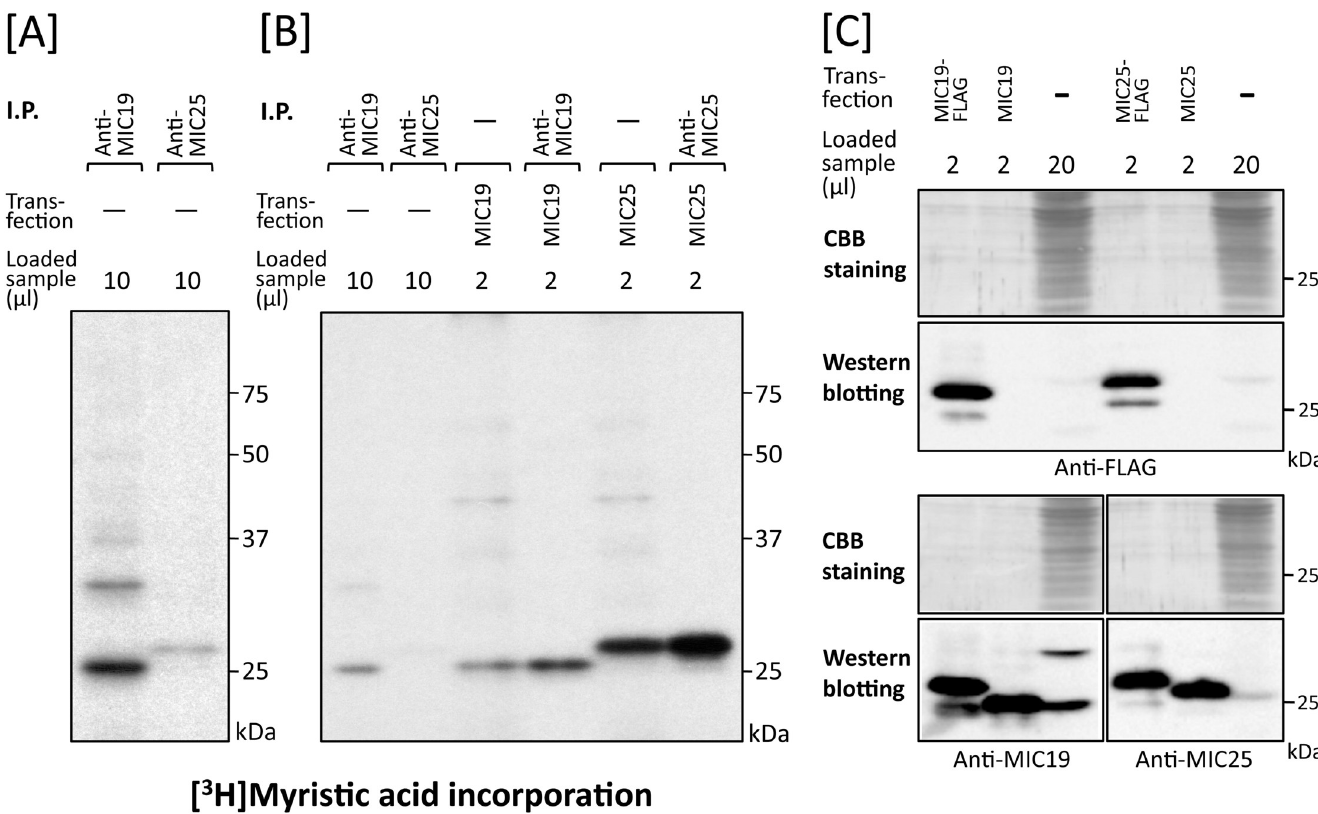
Fig 9. Expression and N -myristoylation of endogenous MIC19 and MIC25 in COS-1 cells. A. Metabolic labeling of endogenous proteins expressed in COS-1 cells with [ 3 H]myristic acid followed by immunoprecipitation with specific antibodies against MIC19 and MIC25 was performed. The labeled proteins were separated by SDS-PAGE and then detected by fluorography. B. Comparison of the molecular size of endogenous N -myristoylated MIC19 and MIC25 immunoprecipitated from COS-1 cells with that of N -myristoylated tag-free MIC19 and MIC25 exogenously expressed in COS-1 cells. [ 3 H]myristic acid labeling of COS-1 cells transfected with cDNA coding for tag-free MIC19 or MIC25 followed by immunoprecipitation with specific antibodies against these two proteins was performed. The immunoprecipitated samples and the samples obtained in A were separated by SDS-PAGE and then detected by fluorography. C. Comparison of the relative amounts of MIC19 and MIC25 expressed in COS-1 cells. The expression level of endogenous MIC25 in COS-1 cells was compared with that of MIC19 by western blotting analysis using MIC19-FLAG and MIC25-FLAG as standard proteins. For this analysis, total cell lysates derived from non-transfected COS-1 cells or COS-1 cells transfected with cDNAs coding for MIC19-FLAG, tag-free MIC19, MIC25-FLAG, or tag-free MIC25 were subjected to western blotting analysis using anti-FLAG, anti-MIC19, or anti-MIC25 antibodies.